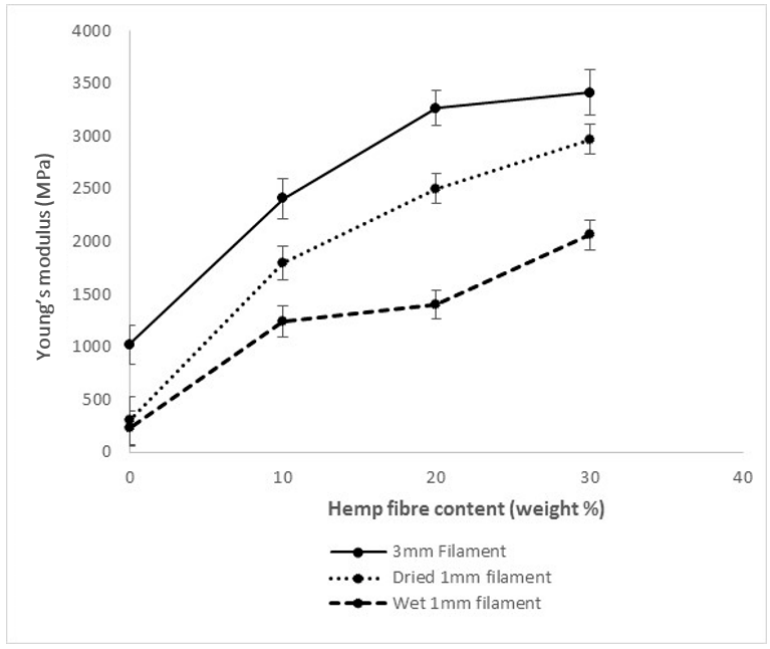
Figure 10. Young’s modulus comparison between hemp reinforced 3 mm, 1 mm wet and 1 mm dry filaments.